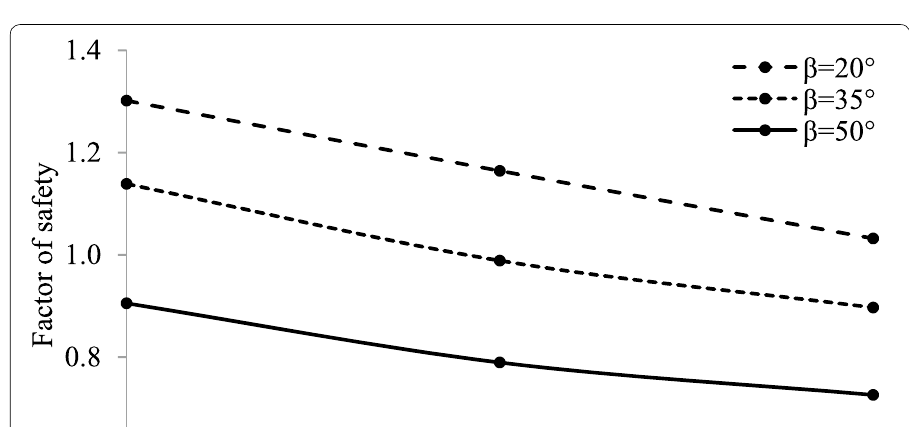
Fig. 6 The variations of factor of safety with at different angle of internal friction for k h γH 0.05 and q/γH =